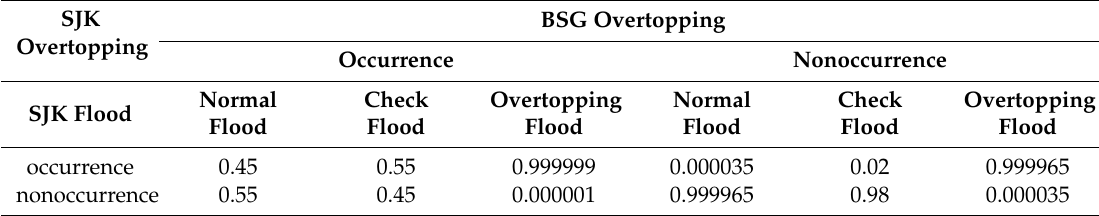
Table 5. The control probability table of Shuangjiangkou (SJK)